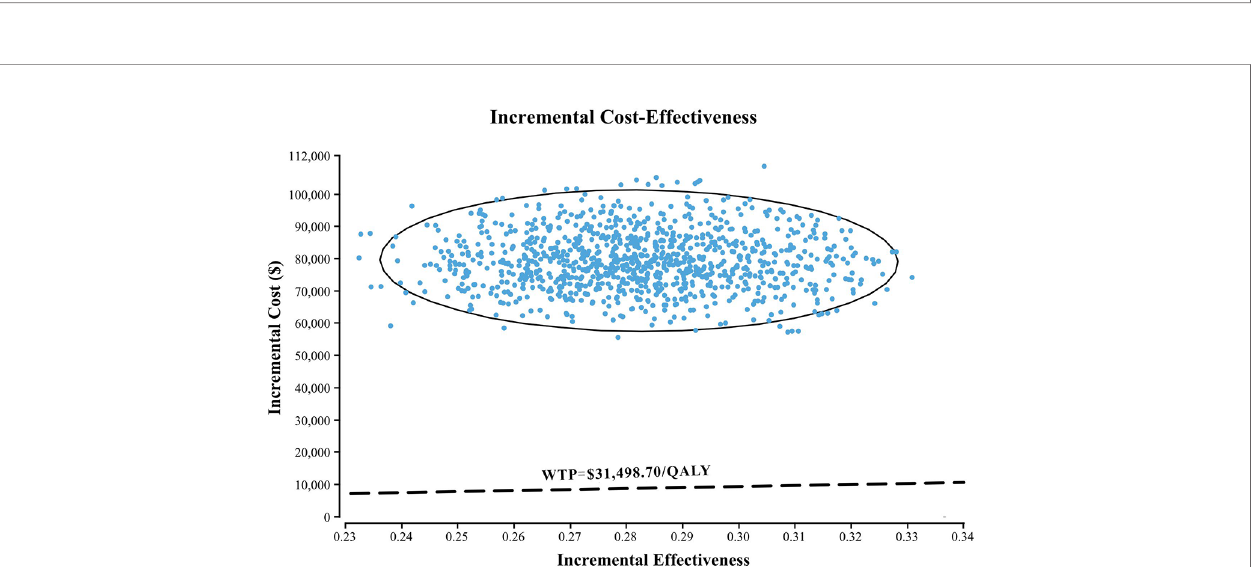
FIGURE 5 | A probabilistic scatter plot of the ICER between the nivolumab plus chemotherapy and chemotherapy. Each dot represents the ICER for 1 simulation. An ellipse means 95% CI. Dots that are located below the ICER threshold represent cost-effective simulations. WTP, willingness to pay; QALY, quality-adjusted life- year; ICER, incremental cost-effectiveness